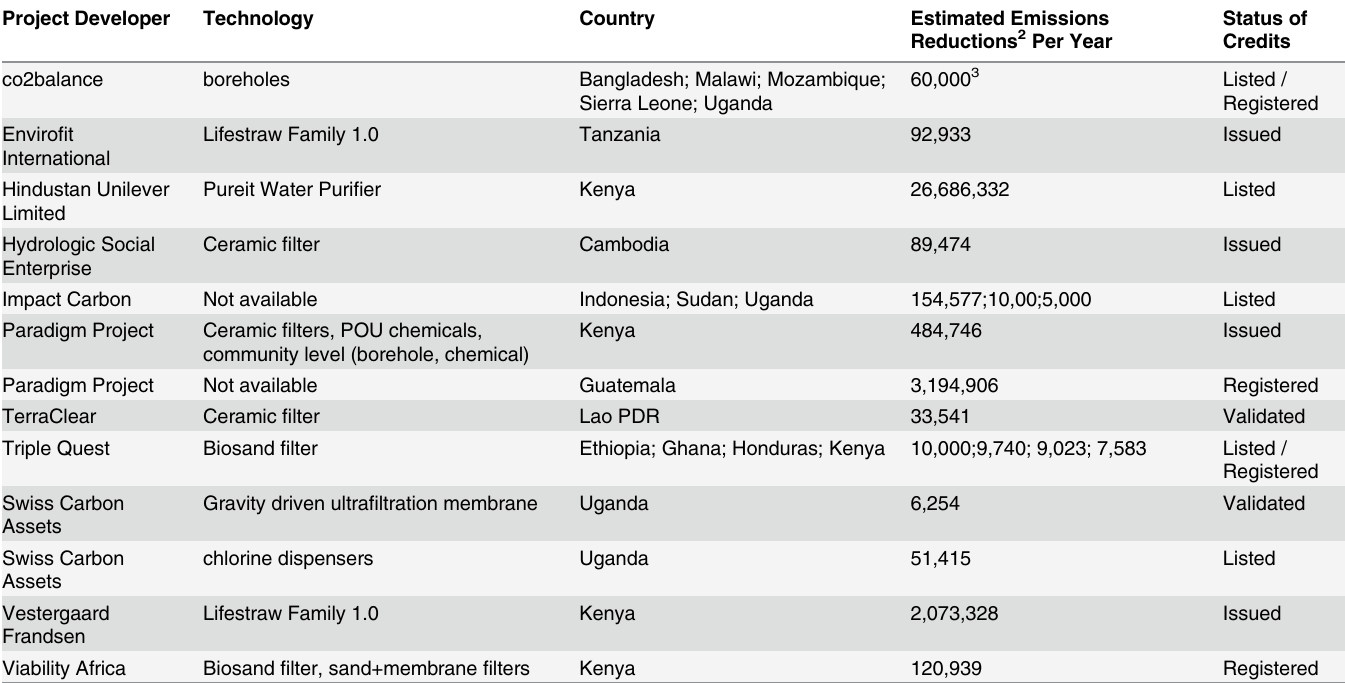
Table 1. Household water treatment projects applying for carbon credits using Gold